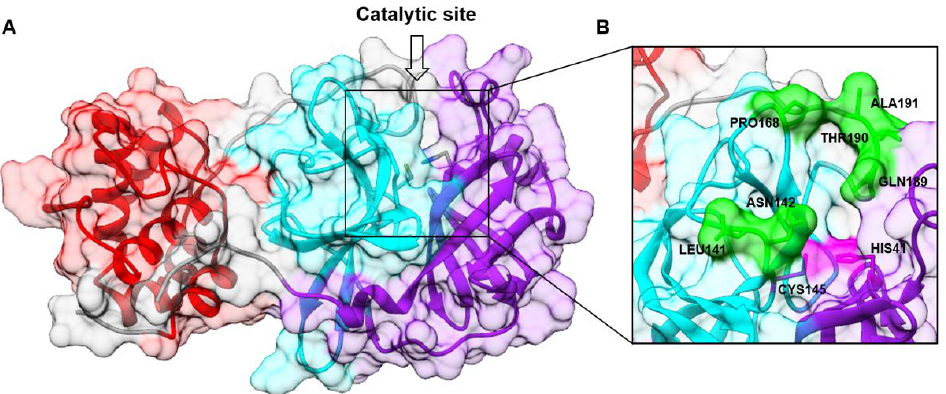
Figure 1. ( A ) M pro structure (PDB ID 7JU7) shown in ribbons and surface representation: domain I (residues 8–101) in purple, domain II (residues 102–184) in cyan, and domain III (residues 201–303) in red. ( B ) A magnification of the catalytic site showing the catalytic dyad (His41 and Cys145) in purple and residues that lie within the binding pocket in green.